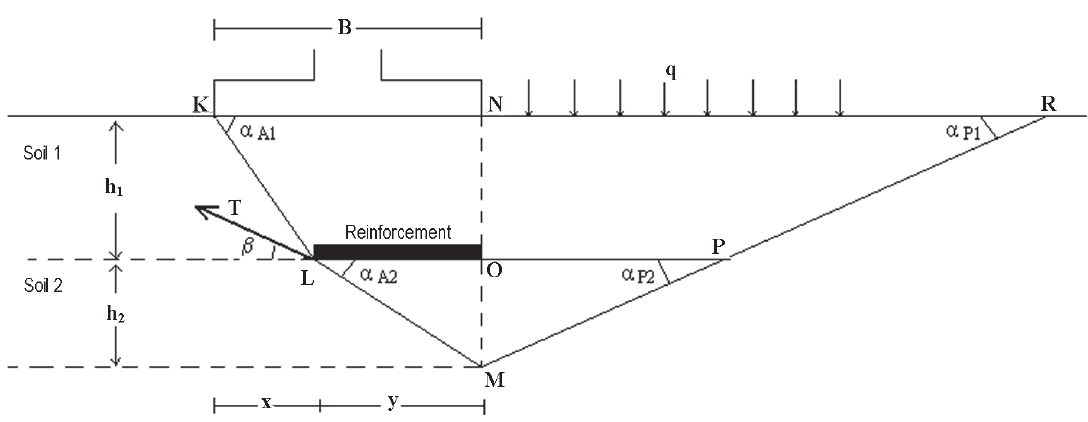
Fig. 1. Simplified slip area with Coulomb wedges and geosynthetic reinforcement